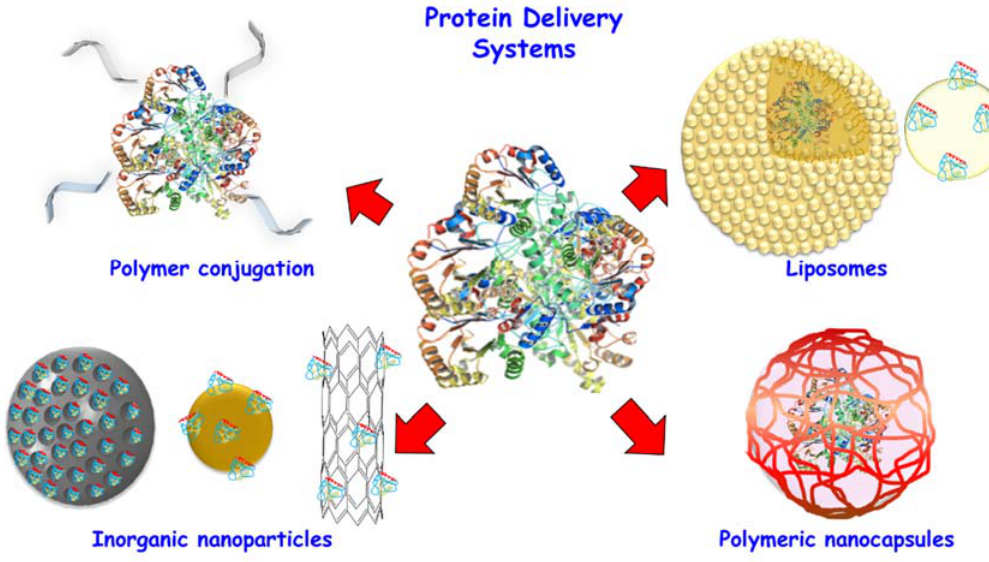
Figure 1. Scheme of different protein delivery systems.